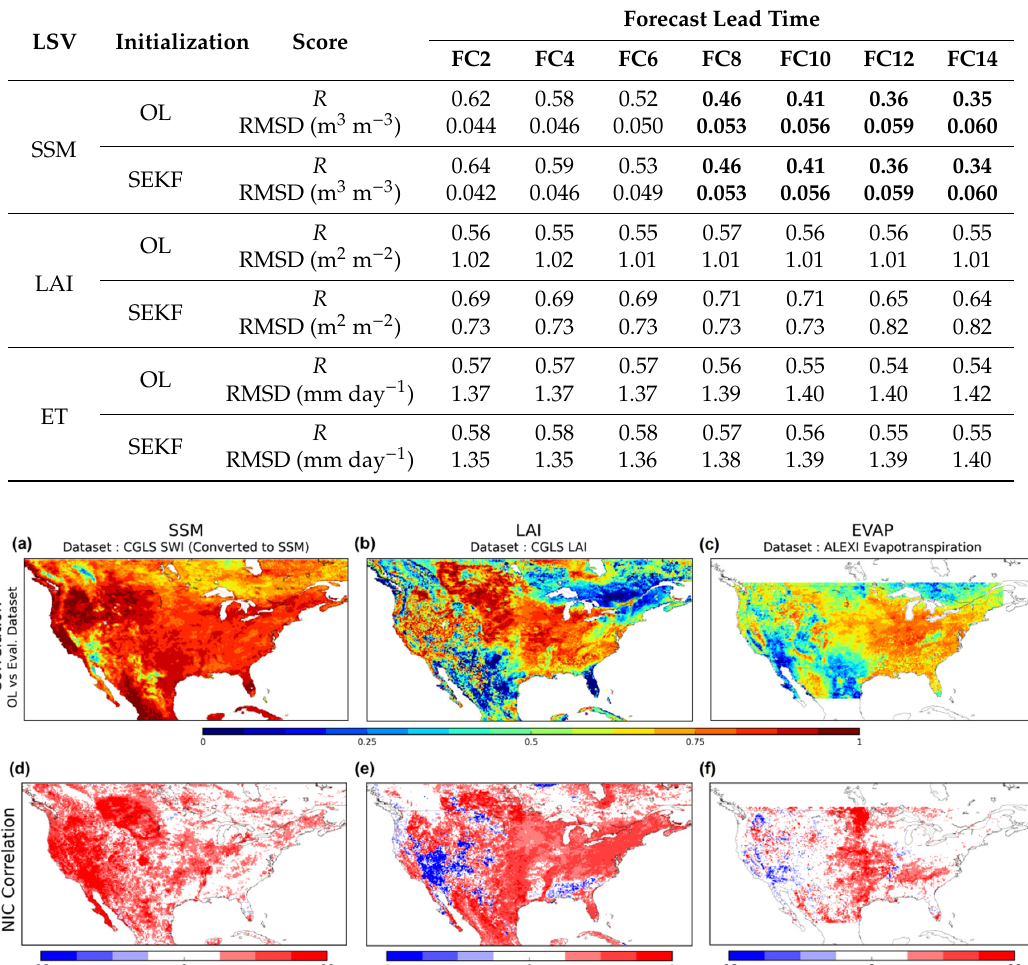
Figure 4. Upper row maps ( a–c ) are of average temporal correlation between LDAS ‐ Monde open ‐ loop (OL) and satellite ‐ derived products for SSM ( a ), LAI ( b ), and ET ( c ) at forecast day 1. Bottom row maps are average normalized information contribution (NIC) correlation impact from the SEKF assimilation for the same variables ( d , e , and f , respectively).